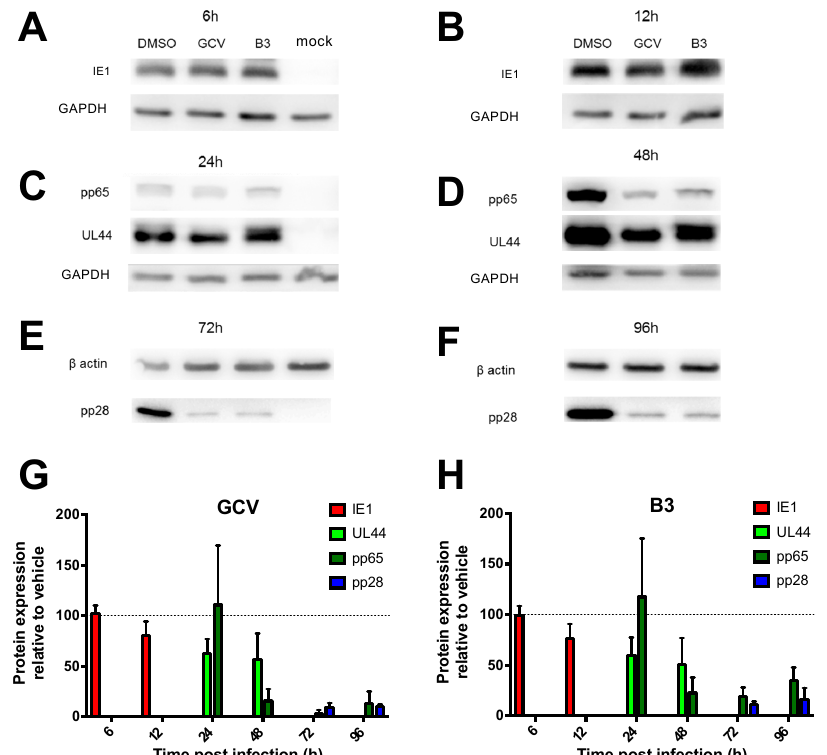
Figure 7. B3 specifically impairs early and late HCMV AD169 gene expression. MRC5 were infected with HCMV AD169 and treated as described in the Materials and Methods section. At the indicated time points p.i., cells were lysed and processed for Western blotting to detect the expression of the immediate early IE1 antigen ( A , B ; at 6 and 12 h p.i.), the early-late antigens ppUL44 and pp65 ( C , D ; at 24 and 48 h p.i.), and the late antigen pp28 ( E , F ; at 72 and 96 h p.i.). GAPDH or β -actin were also detected as loading controls. ( G , H ): Loading controls were used to normalize signal intensity relative to each antigen after treatment with GCV ( G ) or B3 ( H ). Lysates of mock infected cells were analyzed to verify antibody specificity. Data shown are the mean + standard deviation of the mean relative to three independent experiments.